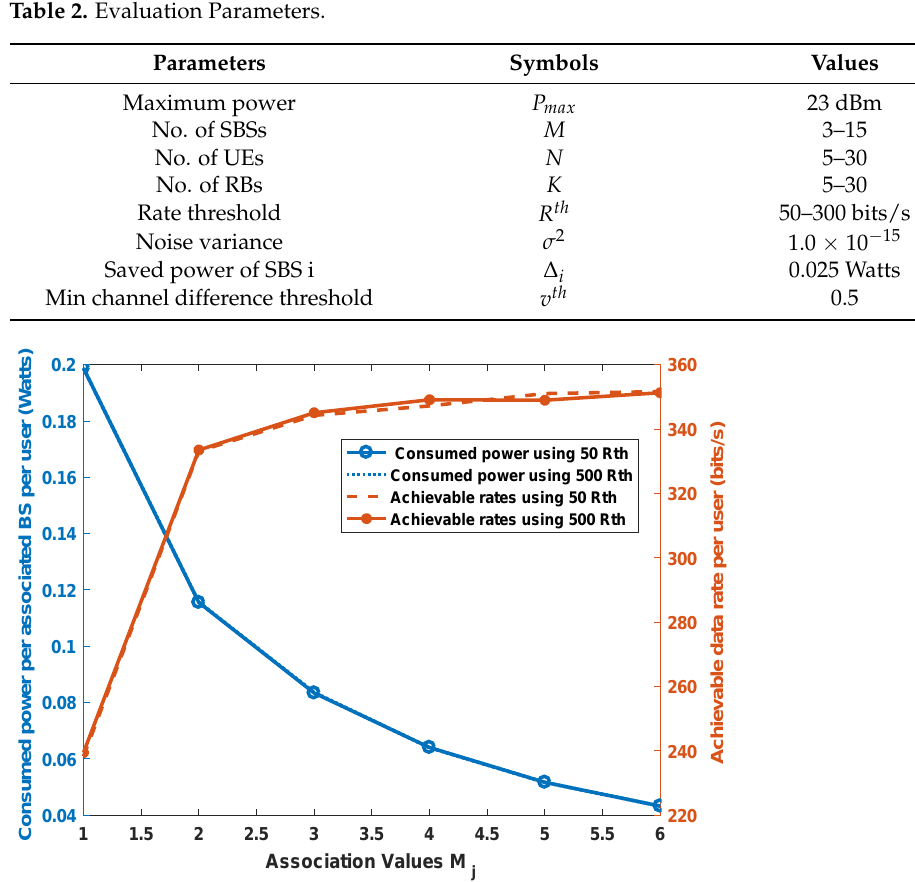
Figure 3. Analysis of Rate allocation in Cooperation regarding